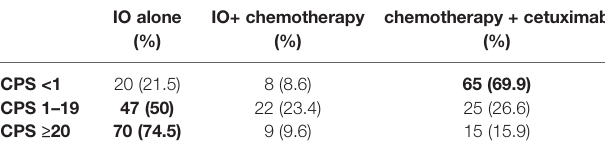
TABLE 5 | Clinical Case 3 — Preferred therapy according to CPS value.